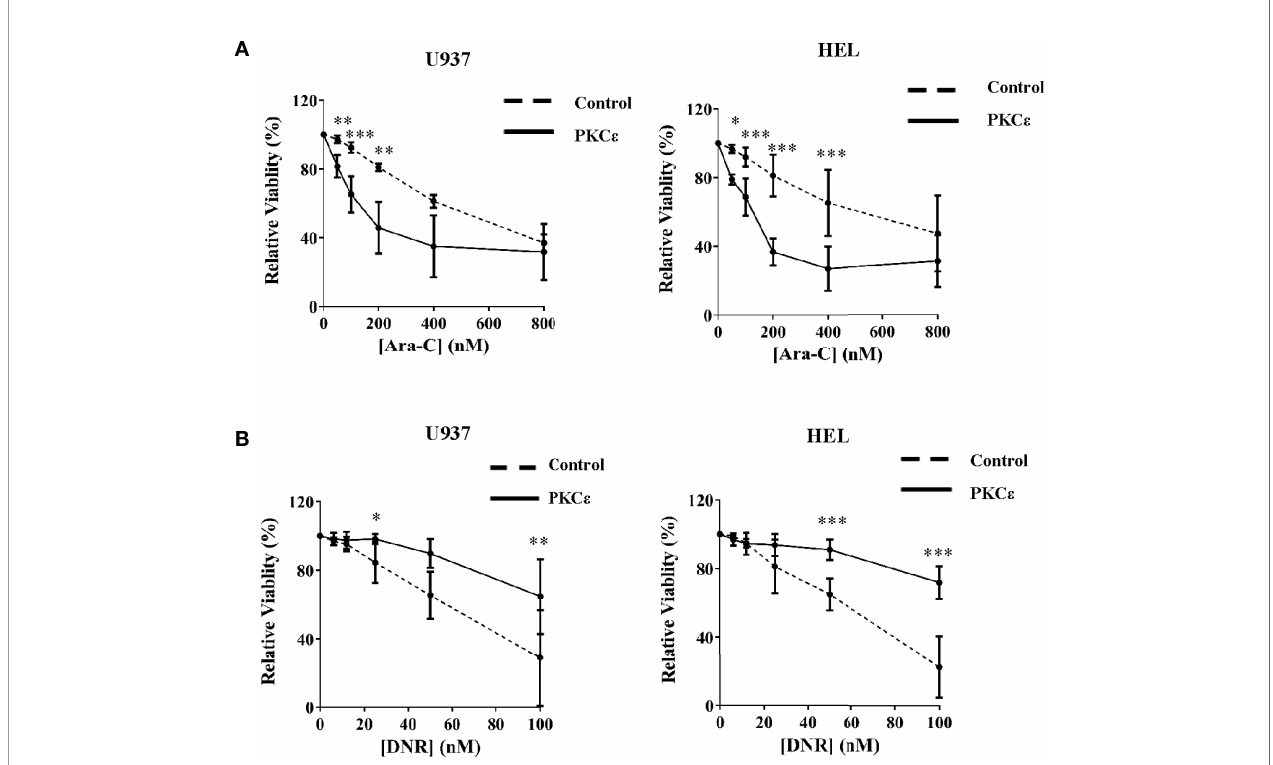
FIGURE 4 | PKC ϵ overexpression selectively promotes resistance to DNR. Line graphs showing the effect of increasing (A) Ara-C and (B) DNR concentrations on the viability of U937 (left) and HEL (right) cells transduced with the control or PKC ϵ overexpression constructs, following 48 hours of treatment. Viability was determined by fl ow cytometry using TOPRO-3 staining ( Supplemental Methods ) and was normalized to the viability of cells treated with the vehicle control (PBS), at the time of harvesting; n=3; data represents mean ±1SD; *p < 0.05, **p < 0.01, ***p < 0.001 comparing test and control cultures at the dose indicated using two- way ANOVA with Bonferroni post-test